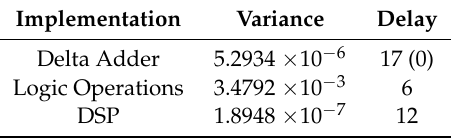
Table 7. Variance and delay of the arithmetic operation multiplication (second input, if different).